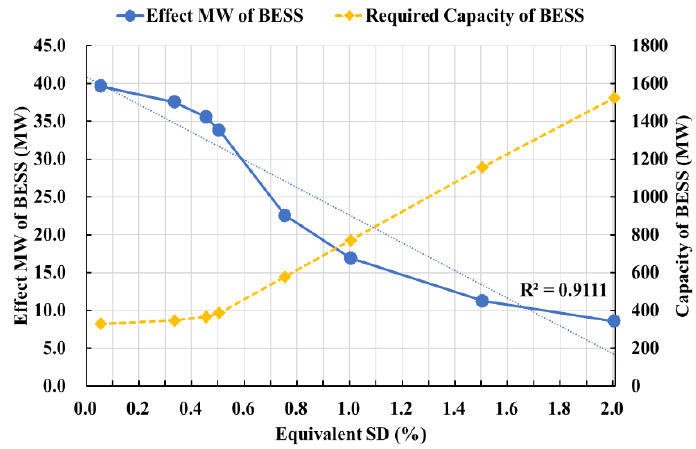
Figure 10. Analysis of BESS Effect MW according to SD.